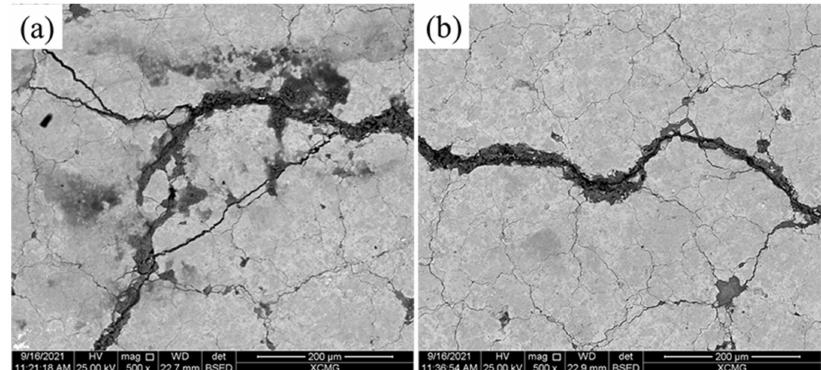
Figure 14. The corrosive surface of ( a ) No. 2 and ( b ) No. 3 suffered BFT.